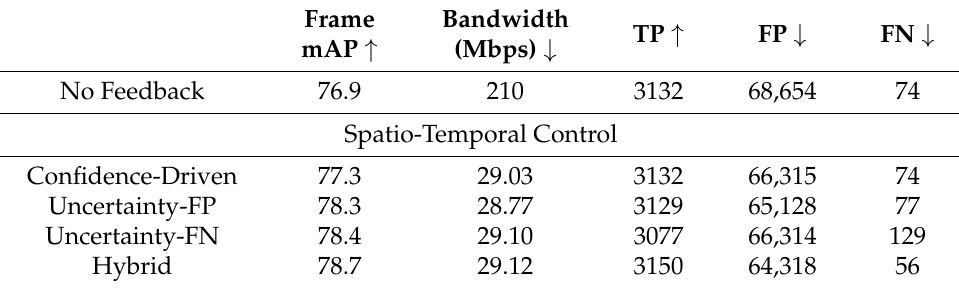
Table 2. Accuracy metrics on the UCFSports dataset.